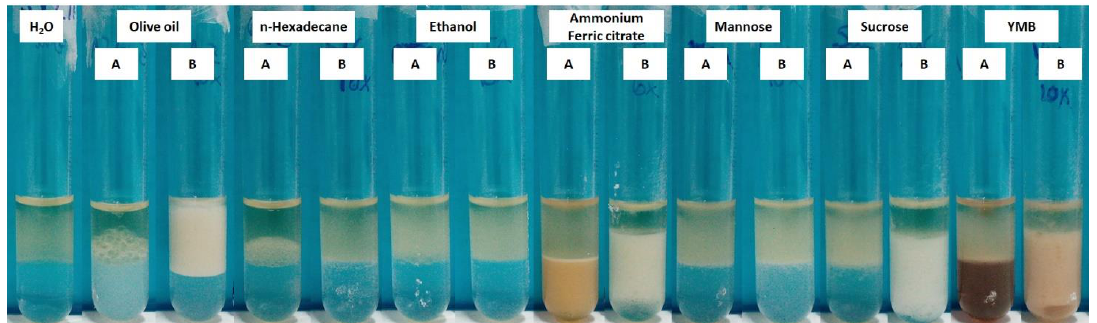
Figure 2. Emulsifying activity (E 24 ) against olive oil of the supernatants (tubes A), resulting from growth with different C-sources and respective BS/BE concentrated extracts (tubes B). Ultrapure water was used as a negative control.